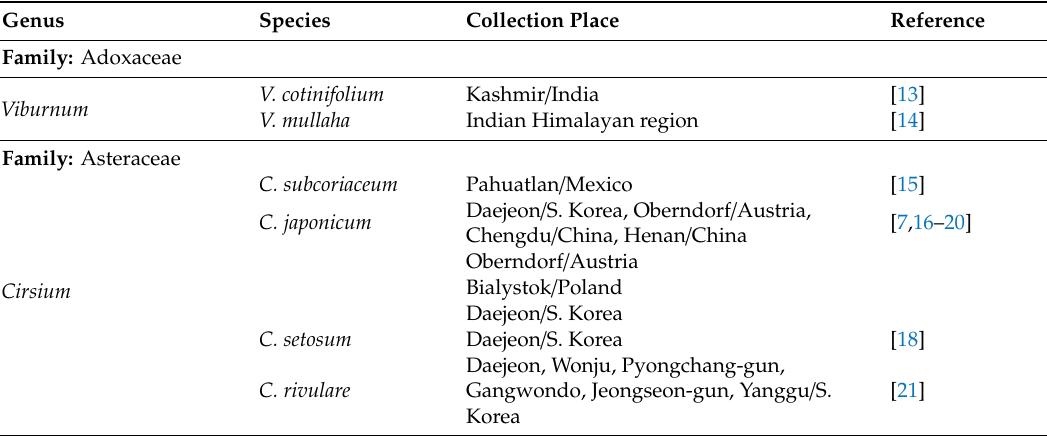
Table 1. Isolation of pectolinarin from the indicated plants, classified according to family, genus and species, and place of collection.